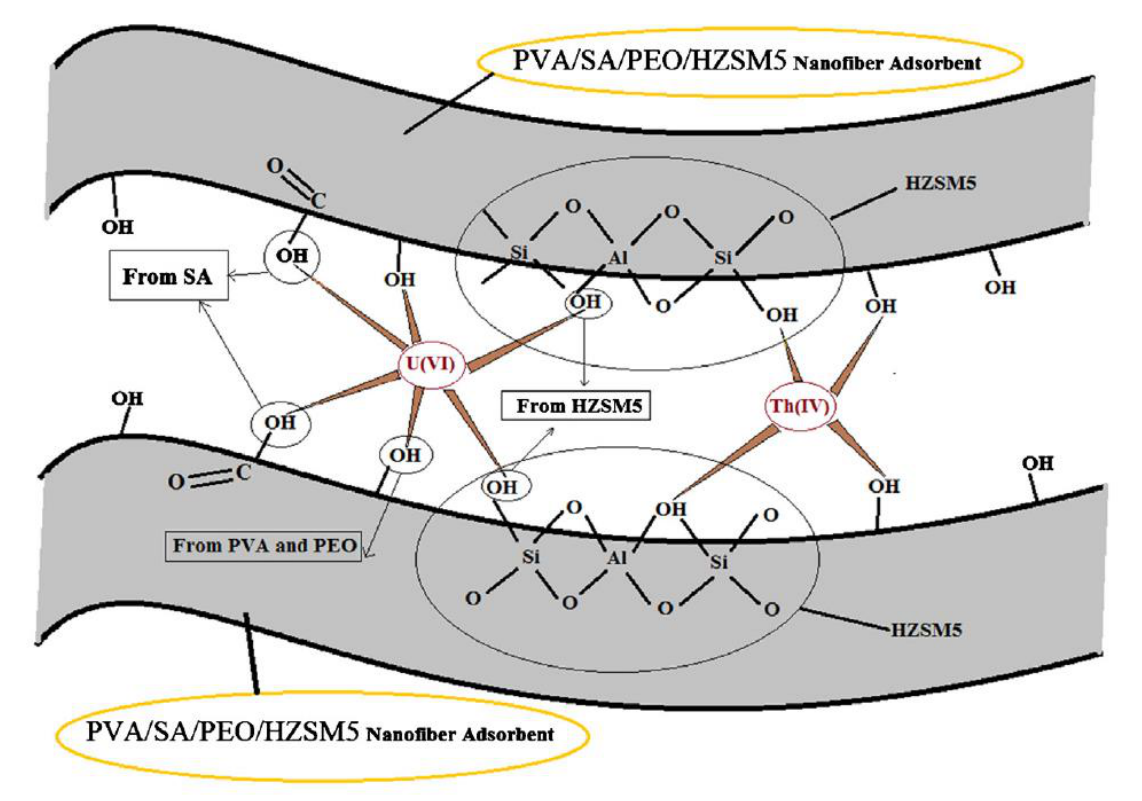
Figure 4. The sorption mechanism of Th(IV) and U(VI) ions on to the PVA/SA/PEO/HZSM5 nanofiber adsorbent (Reprinted with permission from [65]).